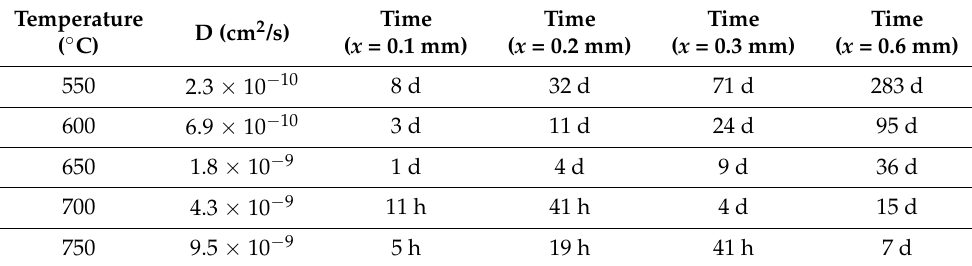
Table 2. Calculation results of Sn diffusion in the Cu